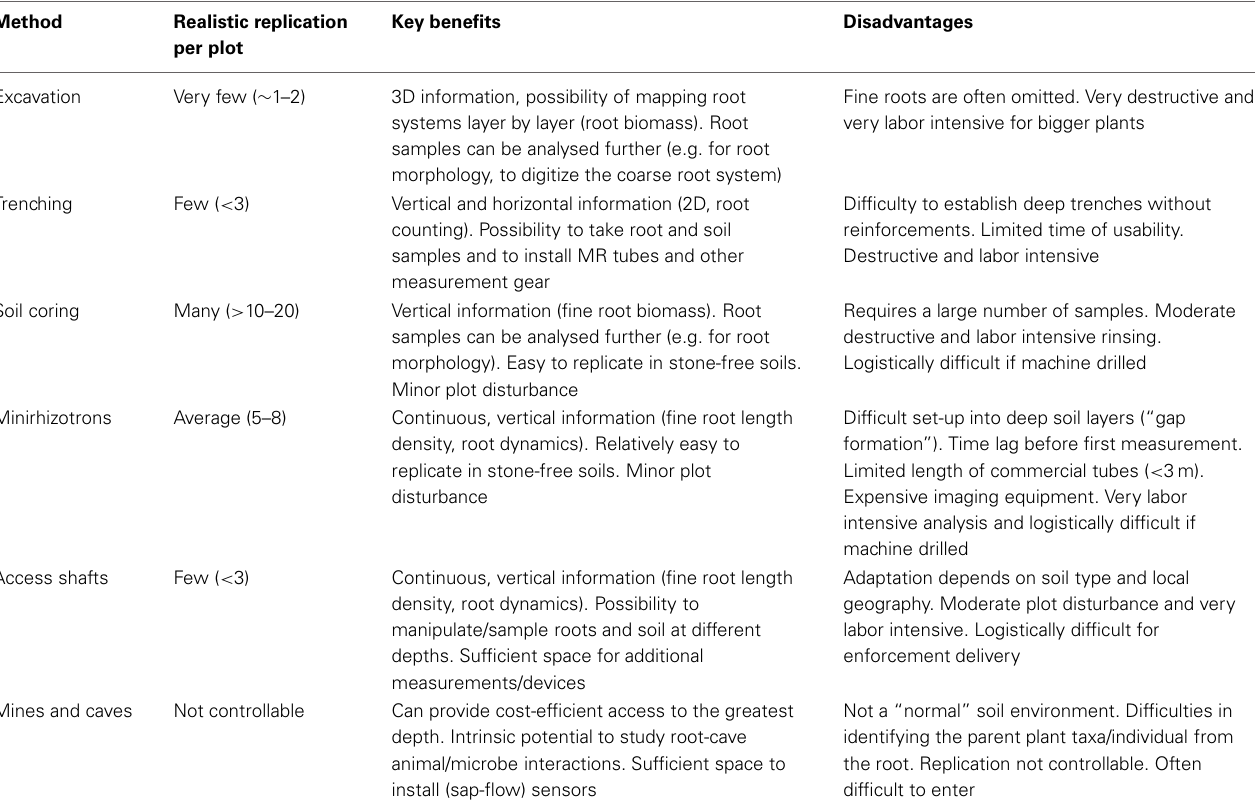
Table 1 | Main advantages and disadvantages of direct (i.e. mechanical, visual) methods to access and to study deep